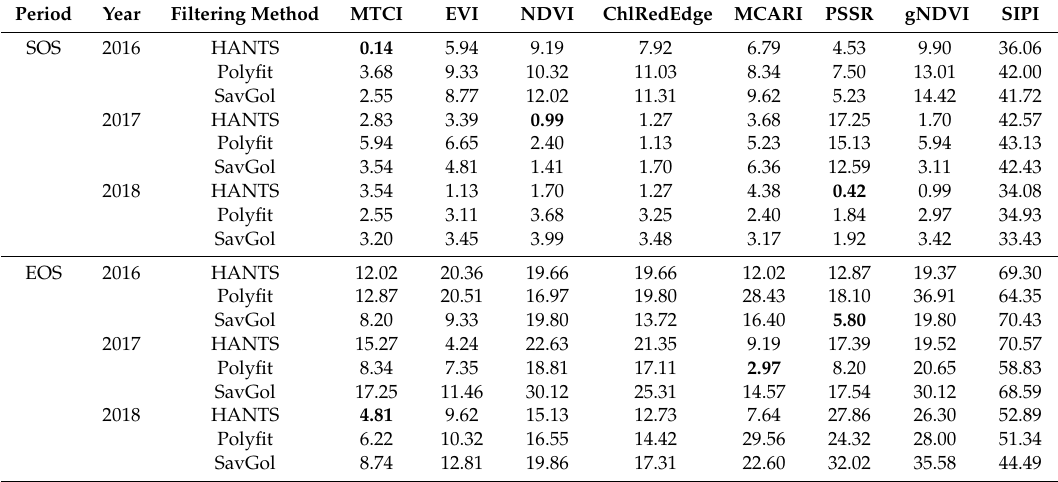
Table 4. Distance, in days, to the 1:1 line between the start of the season (SOS) and the end of the season (EOS) derived from gross primary productivity (GPP) and VIs (see VIs definitions in Table 1) and for each filtering method (HANTS—Harmonic Analysis of Time Series; SavGol—Savitzky–Golay; and Polyfit—Polynomial). The shortest distances are in bold.